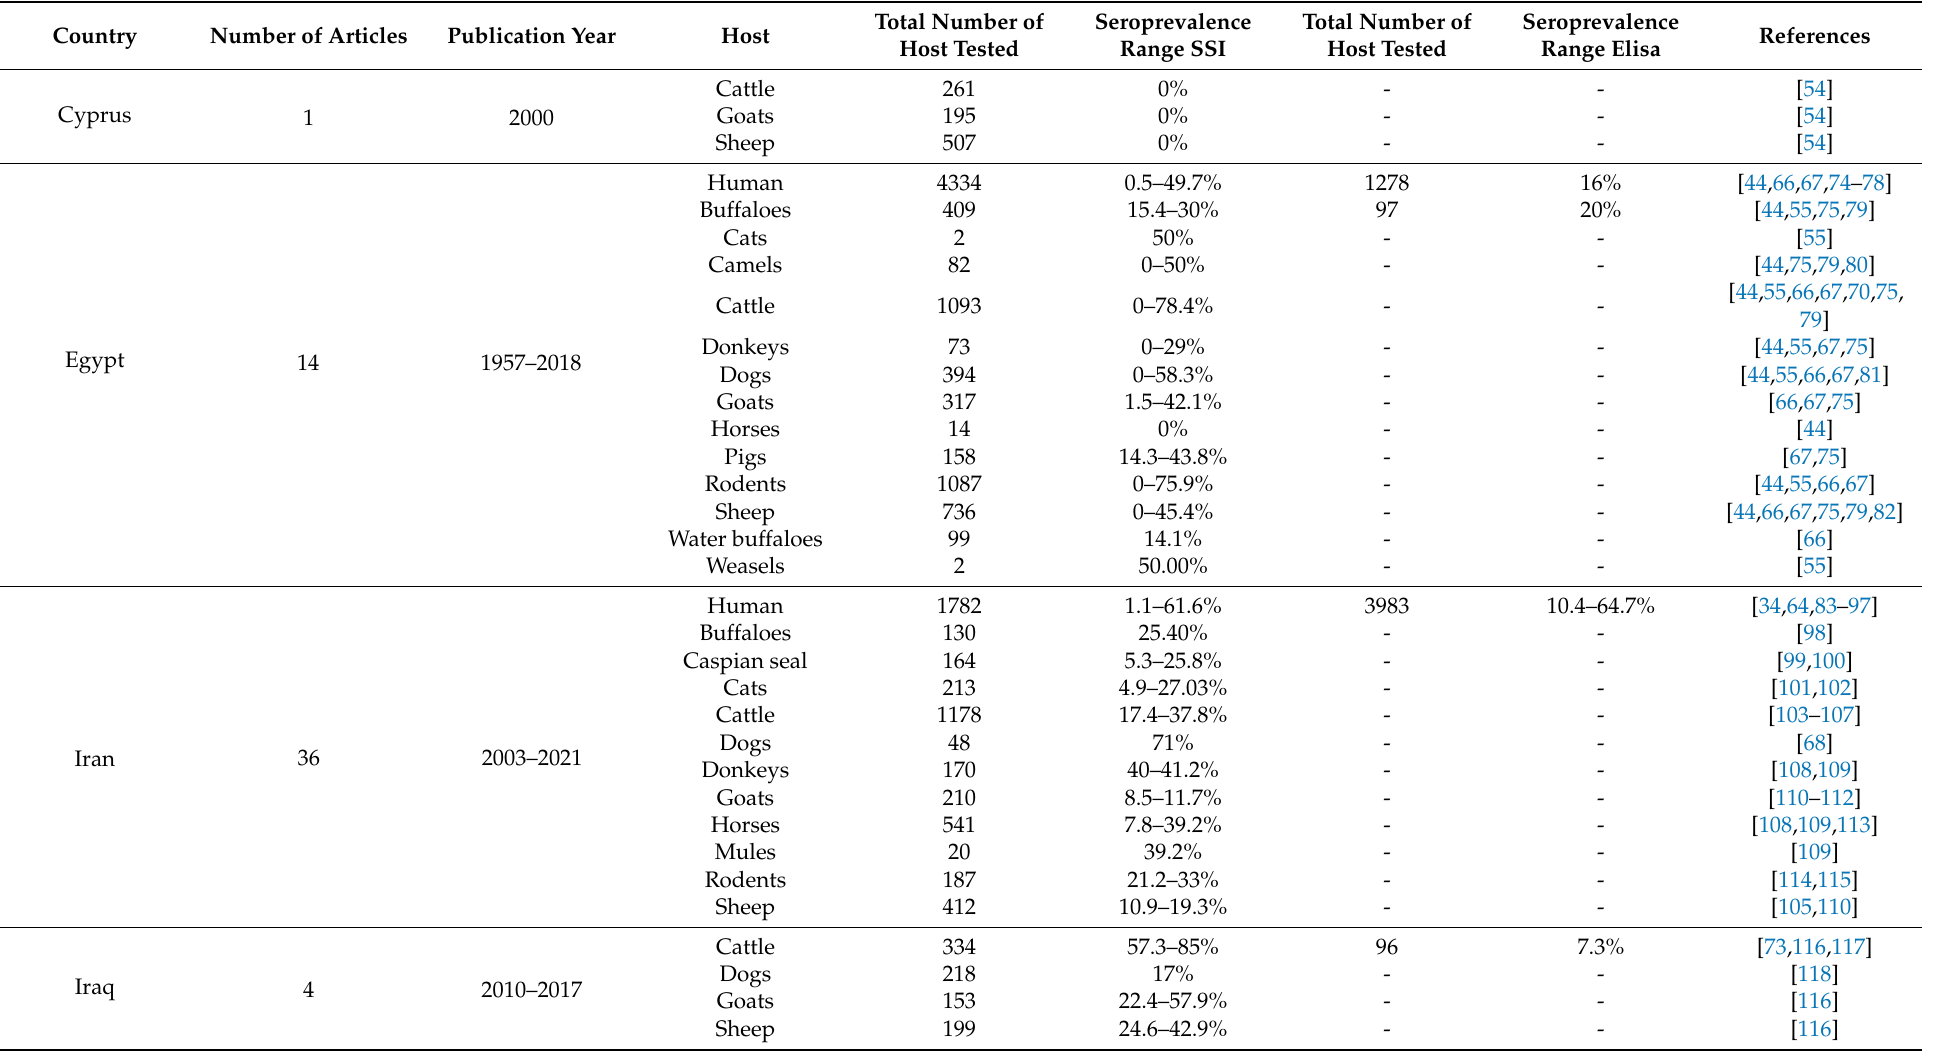
Table 1. Summary of Leptospira seroprevalence in the Middle East according to the test performed (SSI or ELISA) and the country from which the sampling